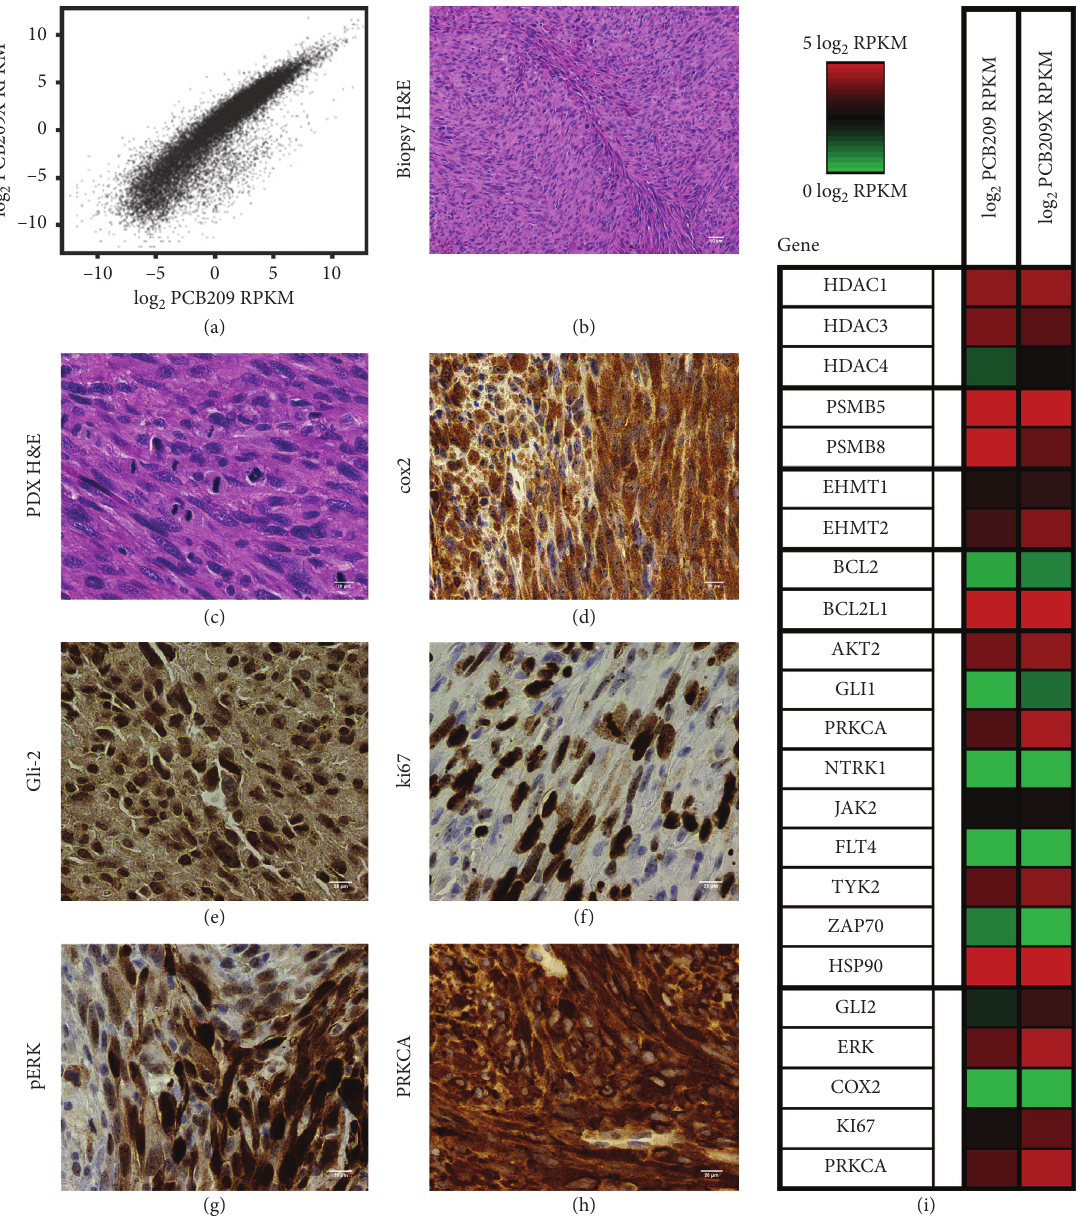
Figure 1: RNA-seq and histology of PCB-209. RNA-seq data for PTIM identified targets and multiple staining images of PCB-209. RNA-seq and histology data were used to partially guide cohorts of the in vivo PDX trial. (a) RNA-seq expression of PCB-209 vs. PCB-209 PDX. (b) H&E stain. (c) PDX H&E stain. (d) Staining for COX2. (e) Staining for GLI2. (f) Staining for ki67. (g) Staining for pERK. (h) Staining for PRKCA. (i) RNA-seq RPKM reported in log 2 format for targets identified by the PTIM analysis informed with RNA-seq data. Red indicates high expression, and green indicates low expression. The left column is the expression for the original cell culture, and the right column is the expression for the culture created from the xenograft